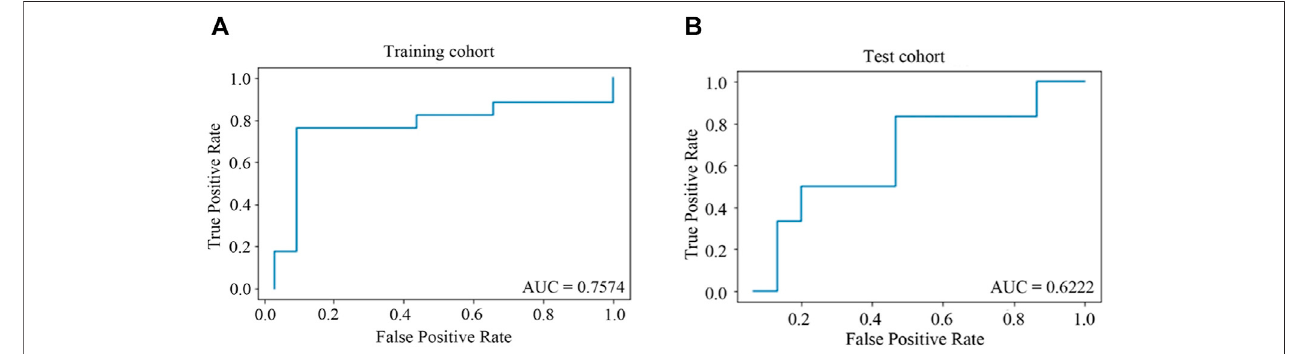
FIGURE 3 | ROC curves for predictors of HD-MTX-induced liver injury in ridge regression model. (A) ROC curve in training cohort; (B) ROC curve in test cohort. When the value of AUC is closer to one, the classi fi cation effect of the model is better.